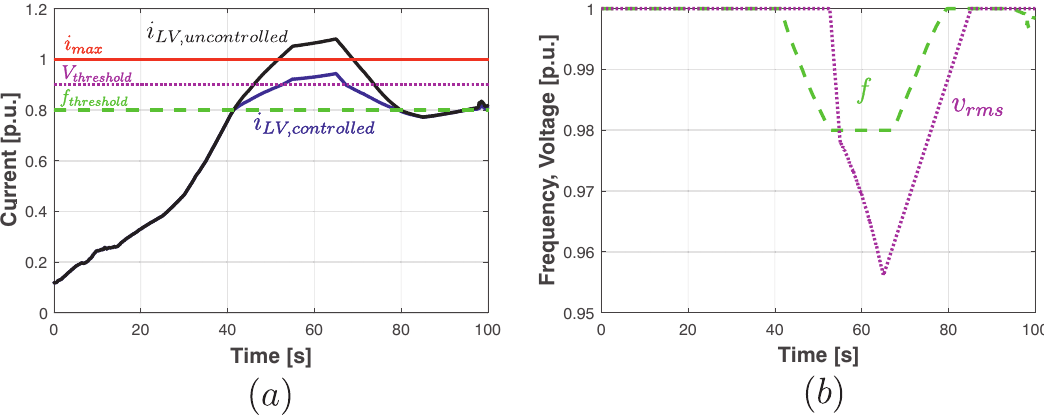
Figure 6. Overload controller simulations: ( a ) ST current without controller (black line), ST current with the proposed overload controller (blue line), frequency controller threshold (dashed green line), voltage controller threshold (dotted magenta line), current maximum limit (red line); ( b ) grid frequency (dashed green line), ST bus voltage (dotted magenta